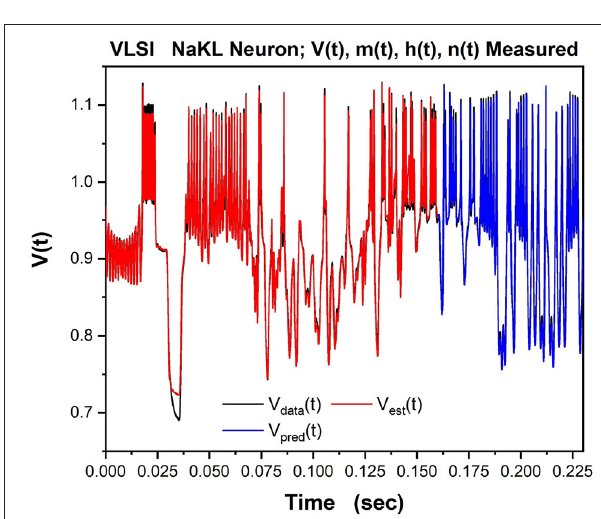
FIGURE 9 | The NaKL VLSI neuron was driven by the waveform for I injected ( t ) V ( t ), m ( t ), h ( t ), n ( t ) seen in Figure 8 . The four state variables for the NaKL { } model were recorded and used in an SDA “nudging” protocol to estimate the parameters of the model actually realized at the manufacturing facility. Here we V data ( t ), V est ( t ), V pred ( t ) display the membrane voltages: –the observed { } membrane voltage response when I injected ( t ) was used, the estimated voltage response using SDA, and finally the predicted voltage response V pred ( t ) from the calibrated model actually on the VLSI chip. In a laboratory experiment, only this attribute of a neuron would be observable.